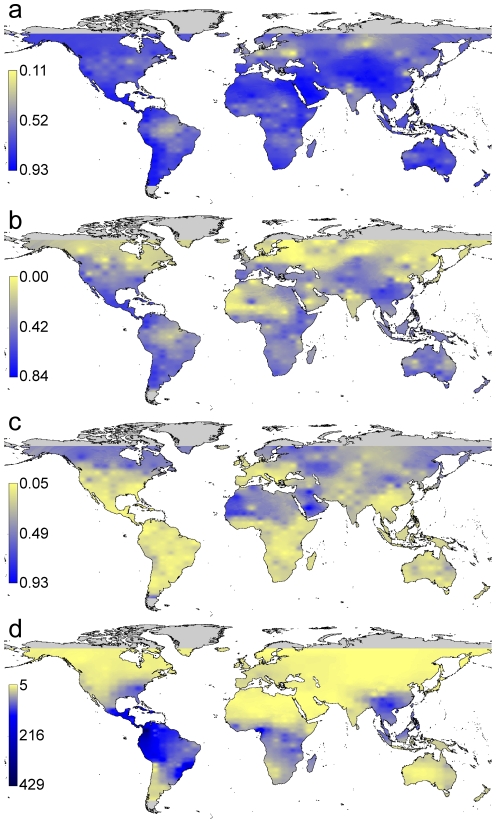
Geographic variation in the beta diversity of regional cells of 250,000 km2, its components and species richness: (a) beta diversity (βSOR), (b) spatial turnover (βSIM), (c) nestedness-resultant dissimilarity (βNES) and (d) species richness in regional cells (i.e. gamma diversity).The maps were spatially interpolated from original data points (as specified in Fig. 1) for representation by a mobile mean procedure. Colours are scaled from yellow (low values) to dark blue (high values). Grey areas represent no data.